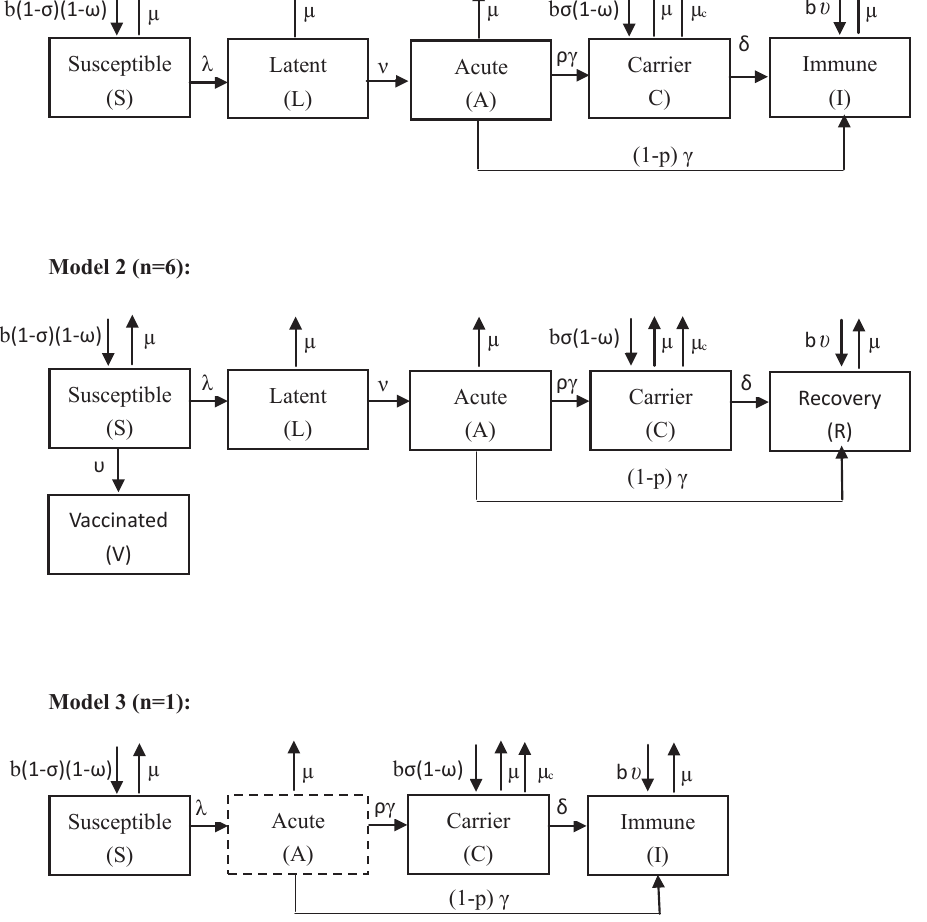
Figure 2. The epidemiological compartments and de fi nitions. Susceptible (S), at risk of infection with HBV; Latent (L), individuals who have been infected but are not yet infectious; Acute (A), Individuals who are in the initial highly infectious stage of HBV infection; Carrier (C), people with chronic HBV infection who are infectious or non-infectious to others; Immune (I), individuals who have recovered from the carrier stage or acute stages of HBV infection or have been successfully immunized; Recovery (R), individuals who have recovered from the carrier stage or acute stages of HBV infection; Vaccinated (V), individuals who have been successfully immunized; “ λ ” , the force of HBV infection; “ ν ” , the rate at which individuals leave the latent class, “ γ ” , the rates at which individuals leave the acute class; “ δ ” , the recovery rate of carriers; “ ρ ” , the probability for an individual su ff ering from acute HBV infection to become a chronic carrier; “ σ ” , the proportion of perinatally infected, “ ω ” , proportion of births with successful vaccination, “ υ ” , the rate of successful vaccination, “ φ ” , the rate of waning vaccine-induced immunity; “ b ” , the birth rate, “ μ ” , the natural mortality rate, “ μ c ” , the HBV related mortality